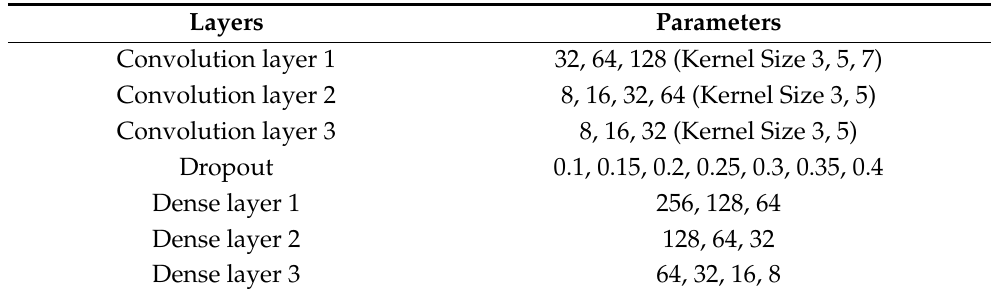
Table 1. Parameter ranges for hyperparameter